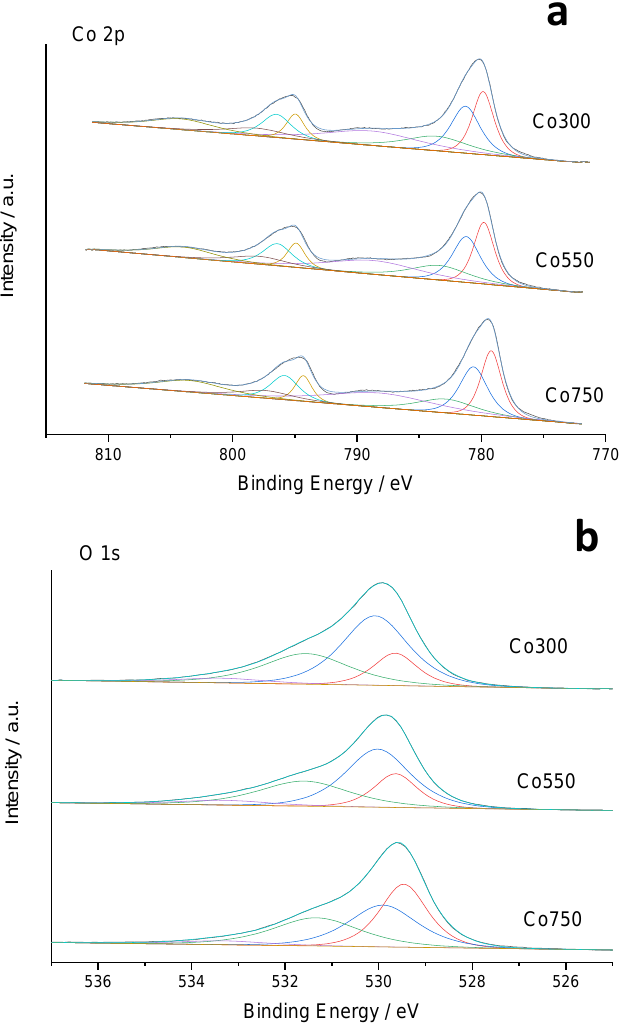
Figure 7. Curve fitting analysis of XPS Co(2p) ( a ) and O 1 s ( b ) core levels for cobalt oxide catalysts calcined at different temperatures.